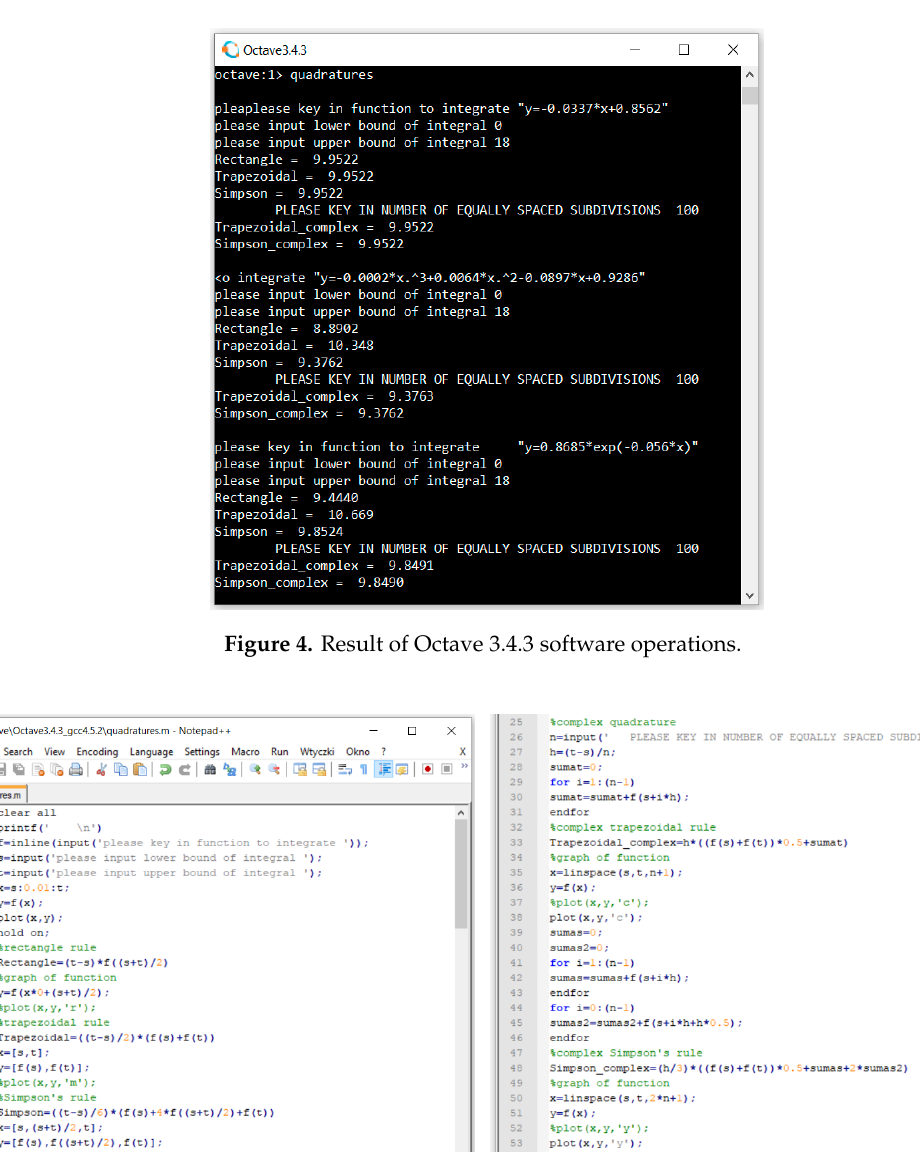
Figure 5. Source code of the numerical integration software.